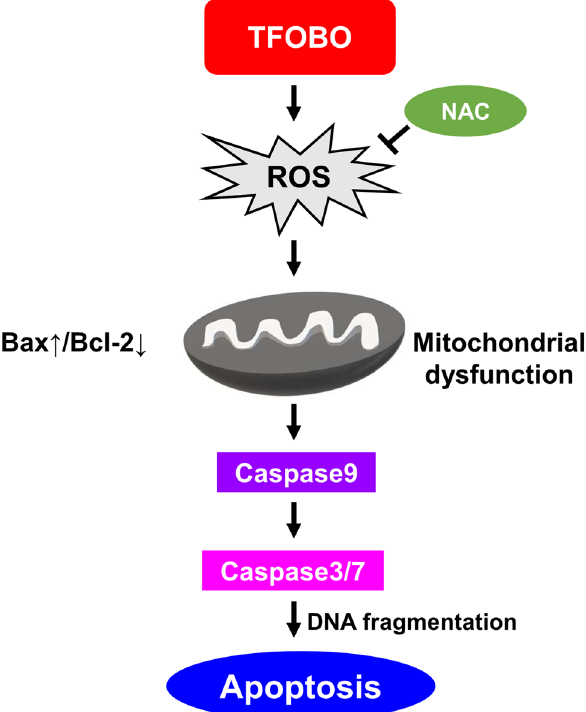
Figure 4. The mechanism for TFOBO-induced apoptosis in THP1 cells via ROS-mediated intrinsic